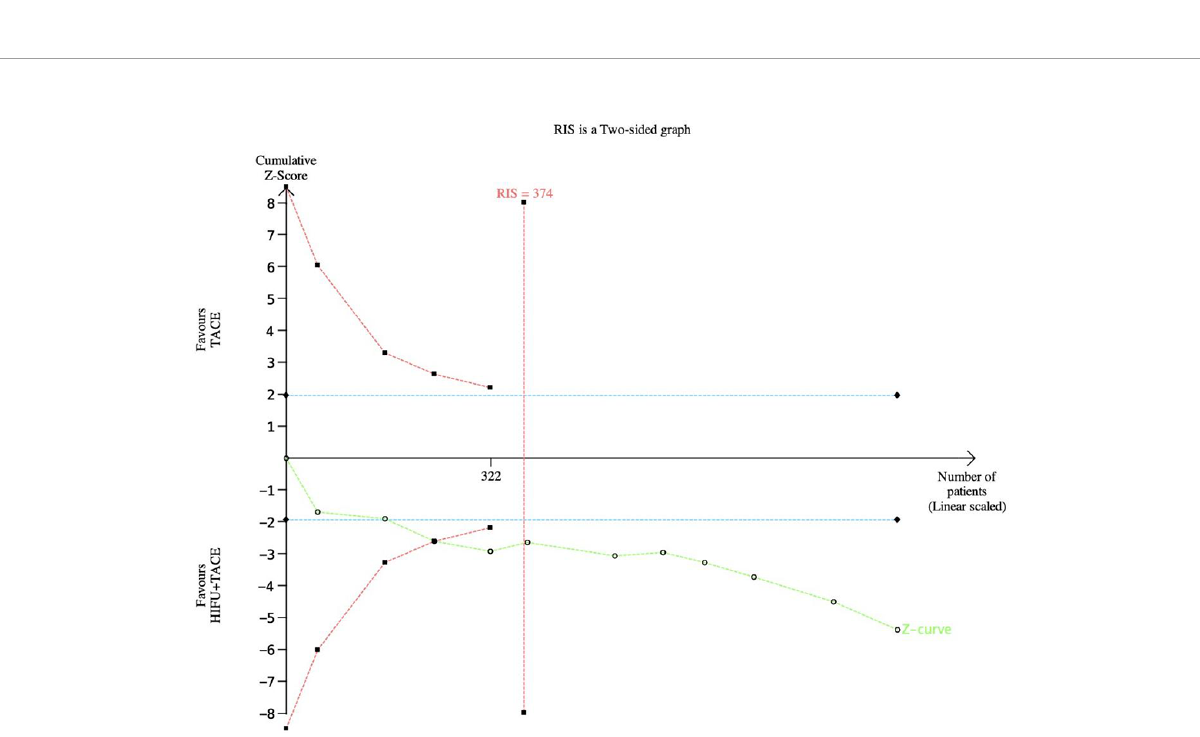
FIGURE 12 TSA graph of tumor response rate. The pink line represents RIS, the blue line represents the traditional bound, and the green line represents the Z